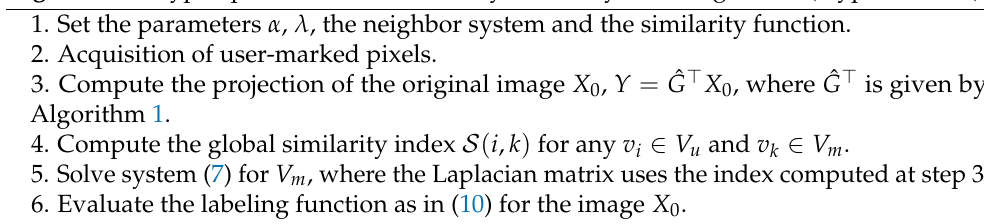
Algorithm 2 Hyperspectral Random Walk by Similarity Index algorithm (HyperRaWaSI)